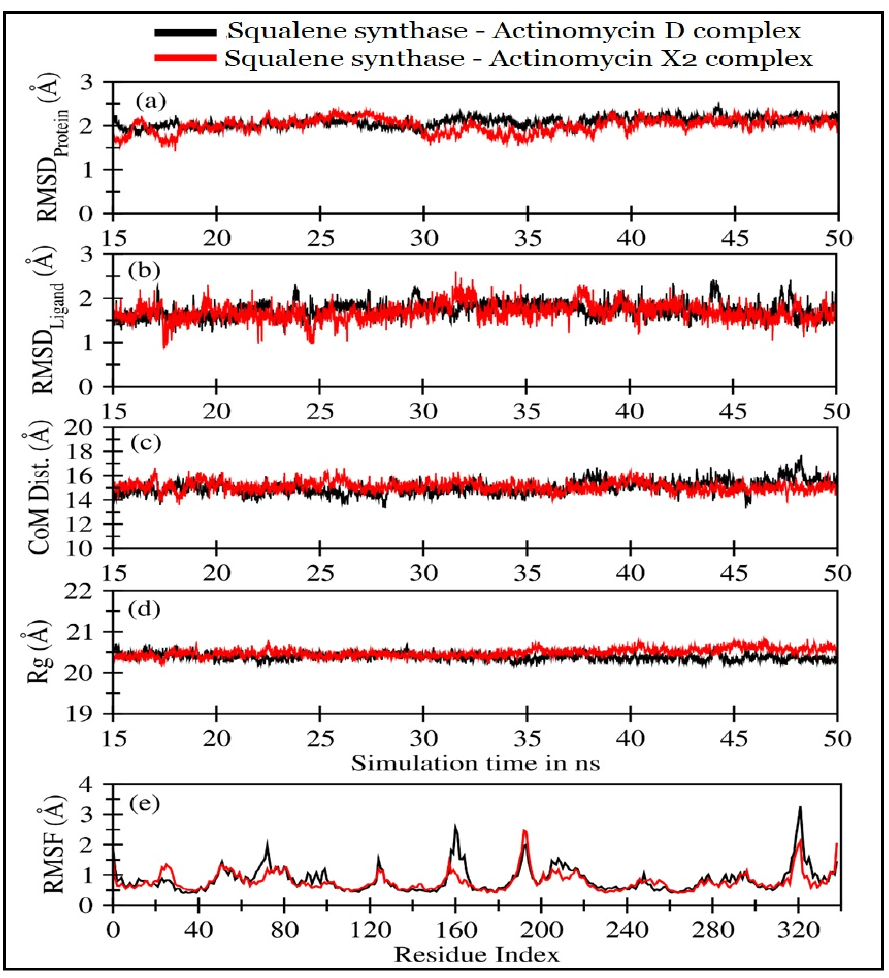
Figure 8. Various trajectory analyses for the squalene synthase complexed with actinomycin D (black lines) and actinomycin X 2 (red lines): ( a ) RMSD protein , ( b ) RMSD ligand , ( c ) center-of-mass distance between protein and ligand, ( d ) protein’s radius of gyration, and ( e ) RMSF, as calculated from last 35 ns of MD trajectories. RMSD protein , Rg, and RMSF have been calculated using ‘C-alpha’ atoms using Gromacs or Bio3D modules in R programs.